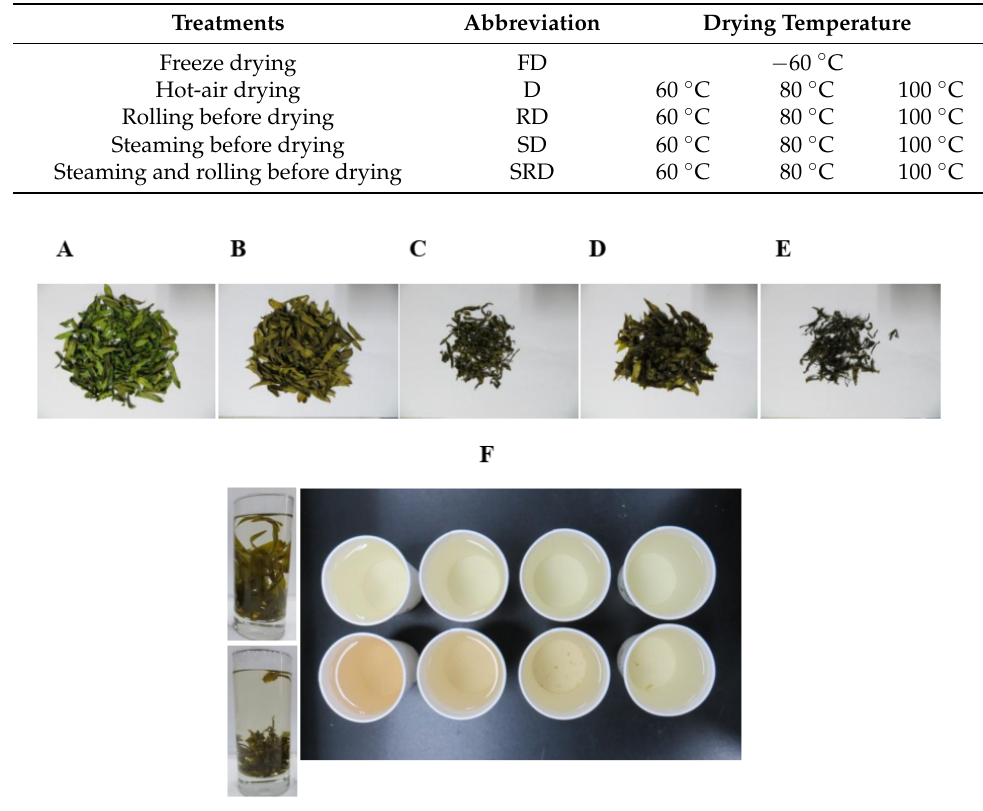
Figure 1. Morphologies of Dendrobium catenatum leaves are shown after exposure to various man- facturing processes: ( A ) freeze drying, ( B ) hot-air drying at 80 ◦ C, ( C ) rolling before drying at 80 ◦